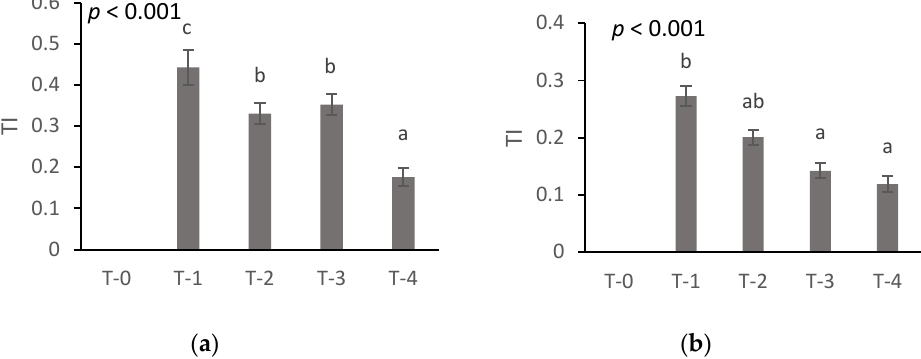
Figure 3. Tolerance index (TI) values for plants non-treated ( a ) or treated with nitrogen ( b ). Different letters denote statistically significant differences at p < 0.05. Error bars represent standard error (T-1 = 25, T-2 = 50, T-3 = 100, T-4 = 150 mg Cr(VI) kg −1 soil).